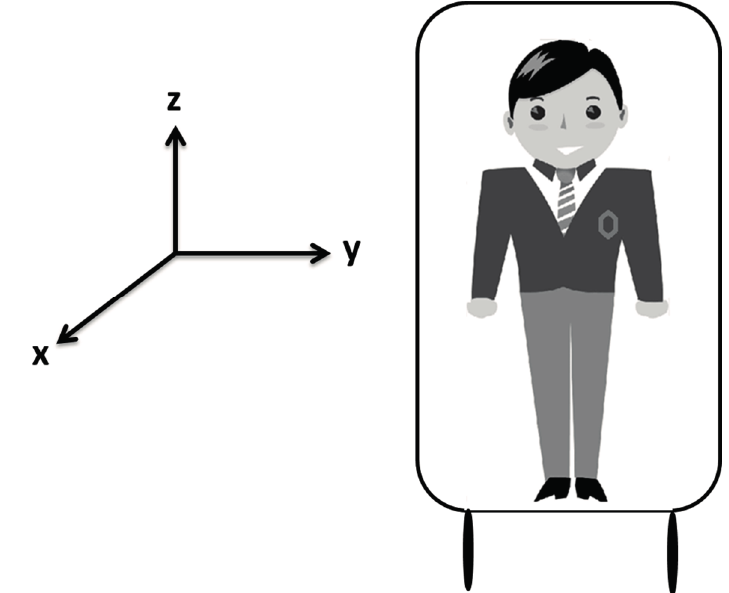
Figure 1. The picture shows three directions (X-, Y-, and